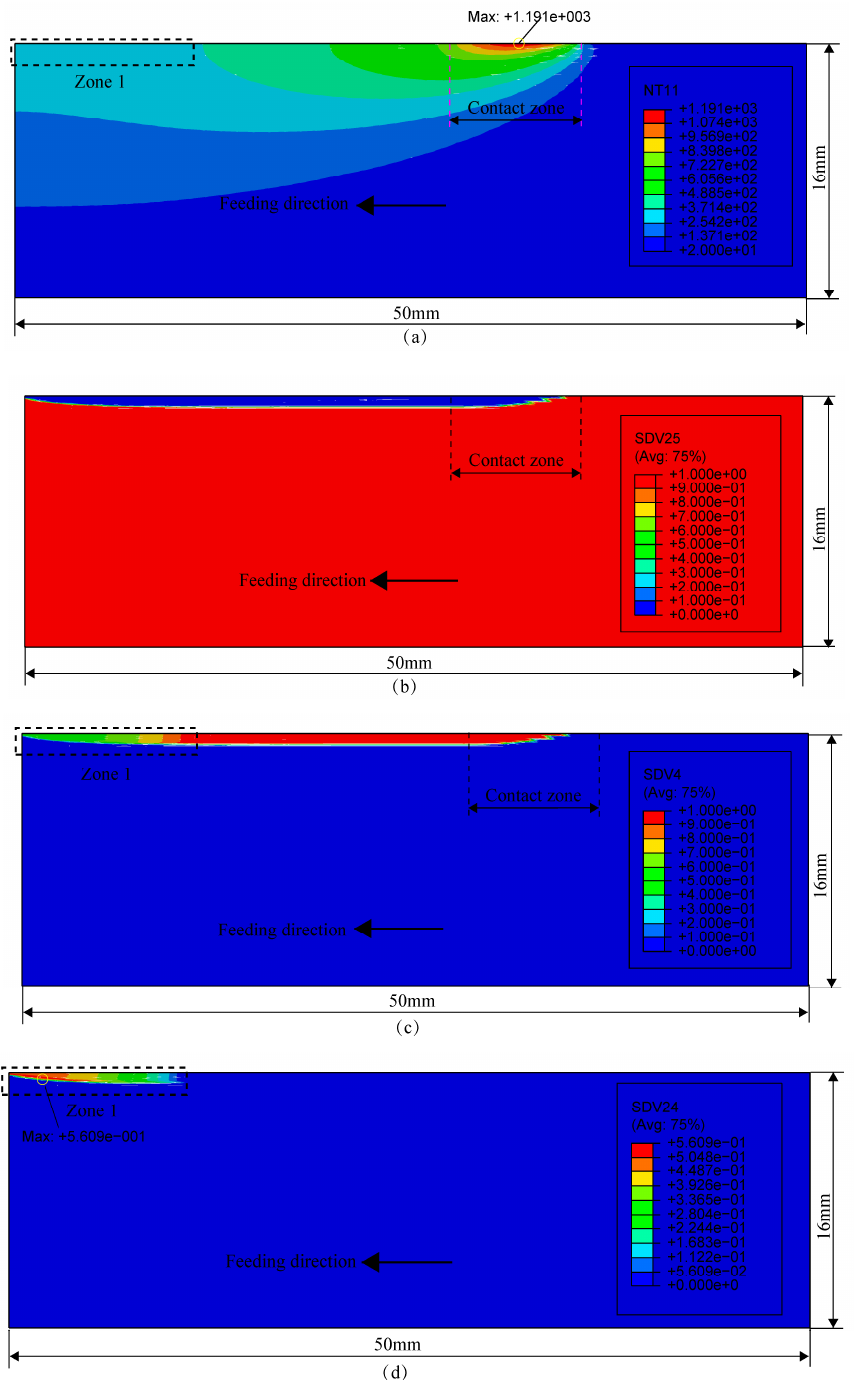
Figure 8. Temperature and microstructure distributions at the moment of 3.576 s: ( a ) temperature; ( b ) ferrite + pearlite; ( c ) austenite; ( d ) martensite.